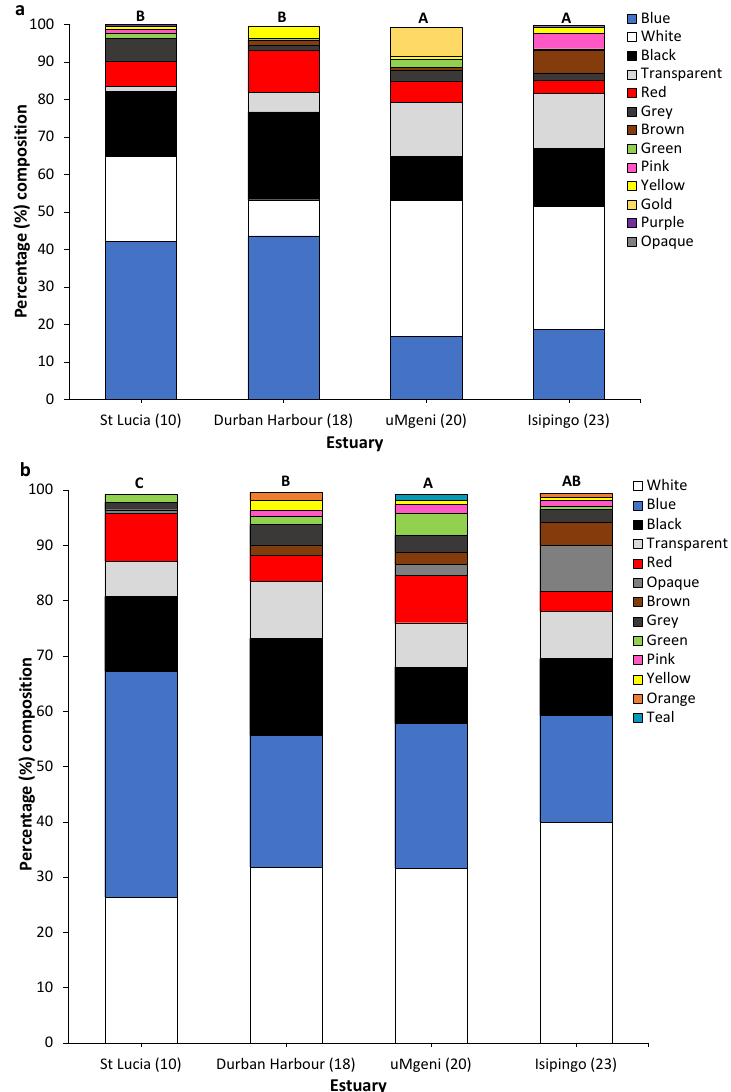
Figure 8. Proportional distribution of different coloured microplastics for ( a ) surface water (n = 12) and ( b ) mangrove sediment (n = 18) at the four estuaries sampled. Uppercase letters indicate significant differences in the proportional distribution of different coloured MPs across estuaries based on combined seasonal data ( p < 0.0001 in both ( a ) and ( b ); ANOVA) . The total disturbance score (TDS) is given within brackets for each estuary on the x-axis.